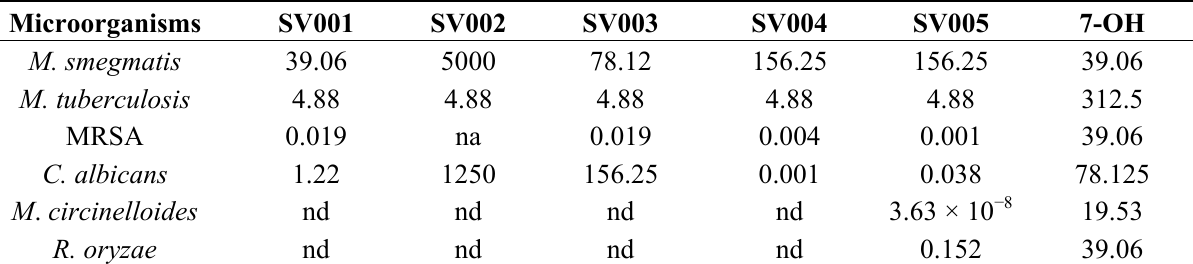
Table 3. MICs values (in μ g/mL) of essential oil